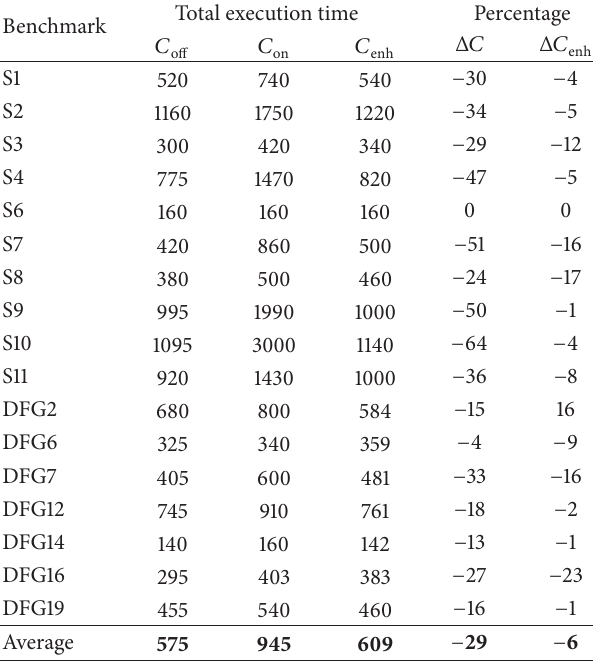
Table 2: Schedulers comparison for total execution time (no learn- ing).